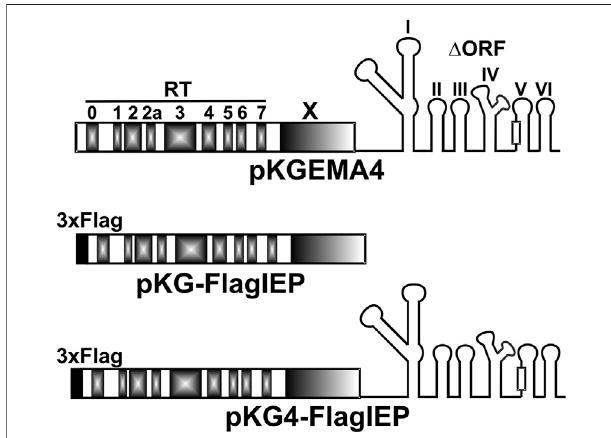
FIGURE 2 | Intron constructs used in the ChIP-Seq experiments. pKGEMA4 contains the wild-type IEP sequence followed by the intron ribozyme with a partial deletion in domain IV, and gives rise to biochemically active RNPs(Nisa-Martínezet al., 2007).Differentdomains inthe IEP are shown in gray. The square in domain V represents the catalytic triad. pKG- FlagIEP encodes the N-tagged IEP with the 3xFLAG epitope (black square) but no intron RNA. Functional RNPs are also produced from pKG4-FlagIEP, but with a 3xFLAG epitope label at the N-terminal end of the